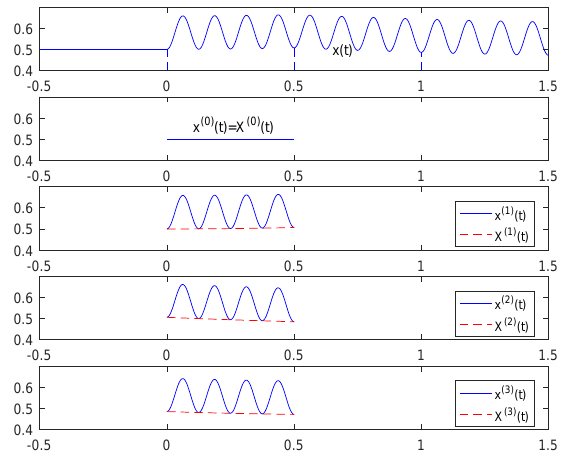
Fig. 1 The solution x of the delay oscillatory problem (8)–(9) (top subplot) is represented by an array ( x ( 0 ) ,..., x ( L ) ) of functions defined in the interval 0 ≤ t ≤ τ ; the four bottom subplots depict these in the case L = 3. Averaging the ordinary differential system without delay satisfied by the ( x ( 0 ) ,..., x ( L ) ) leads to a differential system without delay for the averaged solution ( X ( 0 ) ,..., X ( L ) ) . The functions X ( (cid:96) ) (dotted lines) are patched together to get the solution X of the averaged delay problem that we wish to